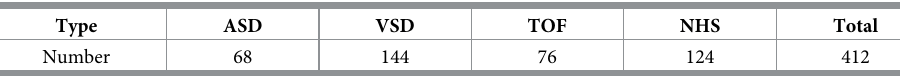
Table 3. Types of samples in our